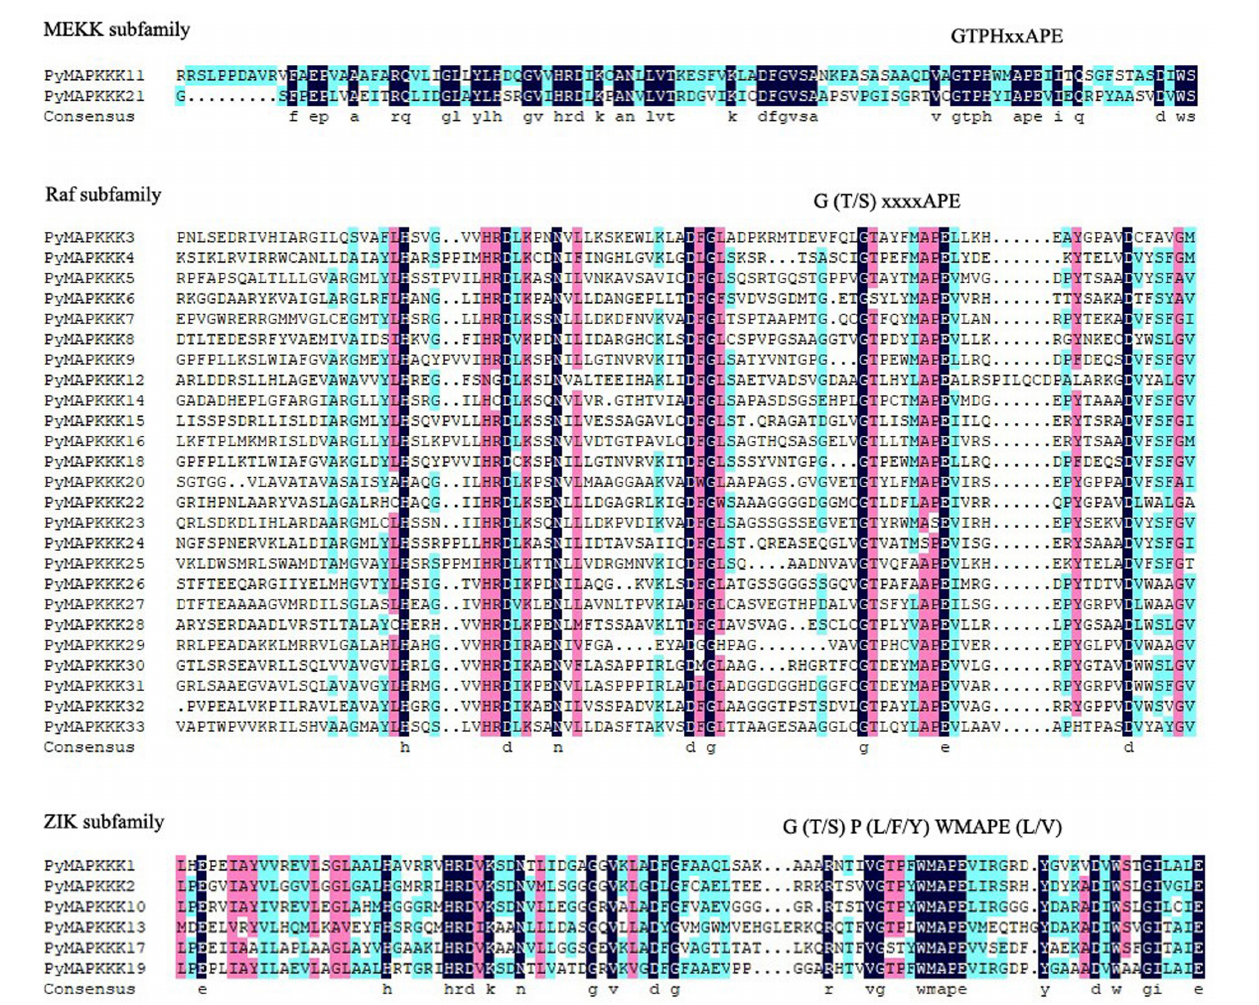
FIGURE 1 | The alignment of MAPKKK protein kinase domain sequence in P. yezoensis . Alignment was performed using MUSCLE (Multiple Sequence Comparison by Log-Expectation) program and DNAMAN. The highlighted part shows the conserved signature motif.